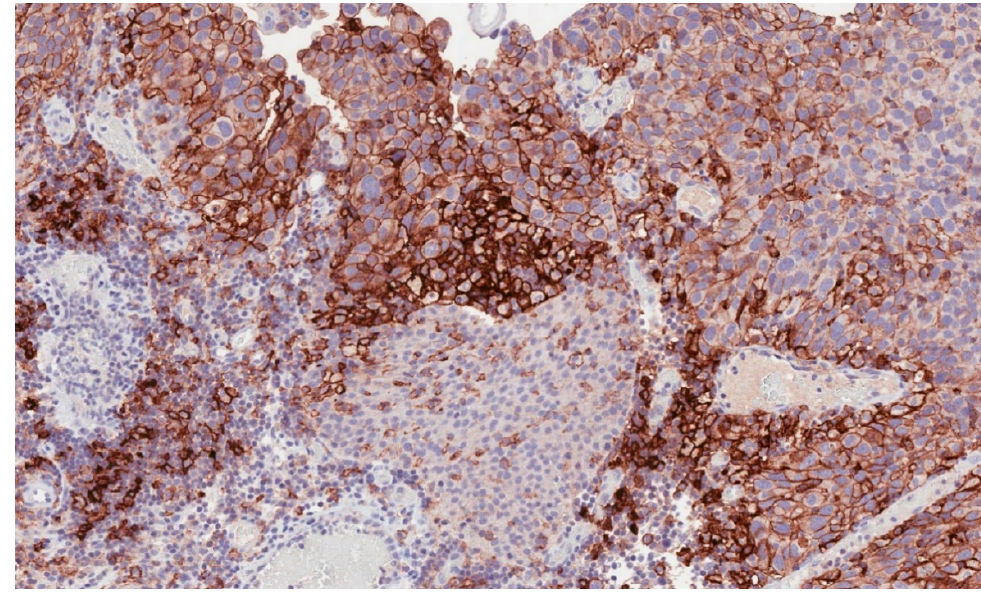
Figure 1. Programmed death-ligand 1 (PD-L1) membranous immunostaining in high-grade urothelial carcinoma (22C3 antibody) (200×).